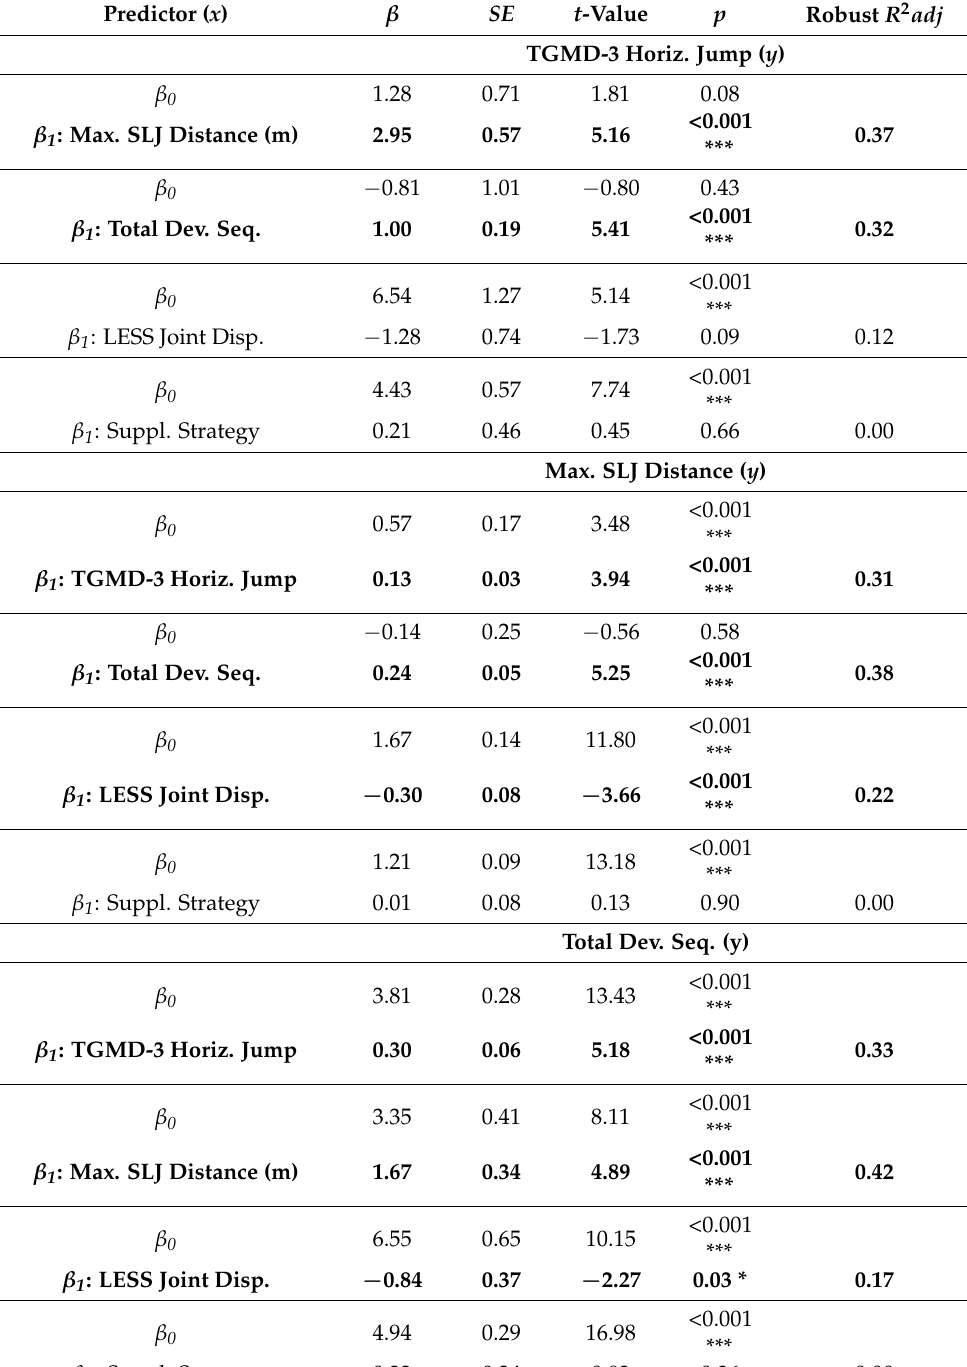
Table 3. Individual robust bivariate regression results between SLJ measures. Predictor ( x